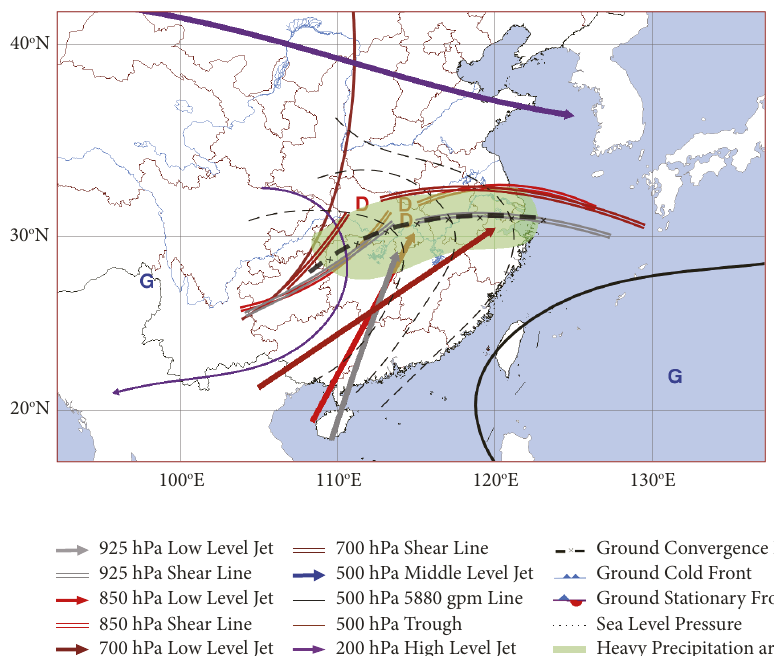
Figure 5: Conceptual model of the Low-Level Vortex and Shear Pattern